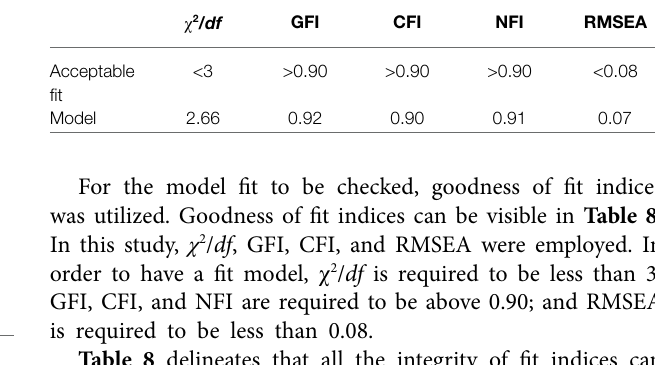
Table 7 delineates the results of Pearson Correlation between all sub-components of WE and all sub-components of TSE.